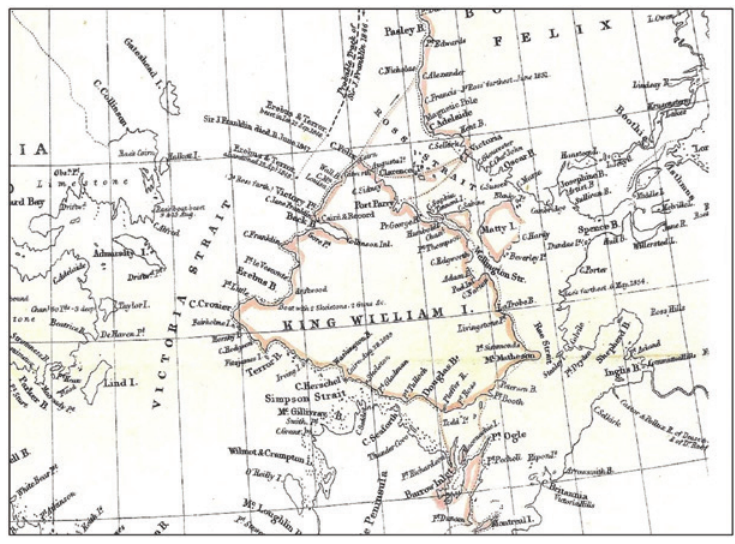
Figure 10. King William Island . Source : McClintock, Voyage of the Fox : from map drawn by John Arrowsmith,